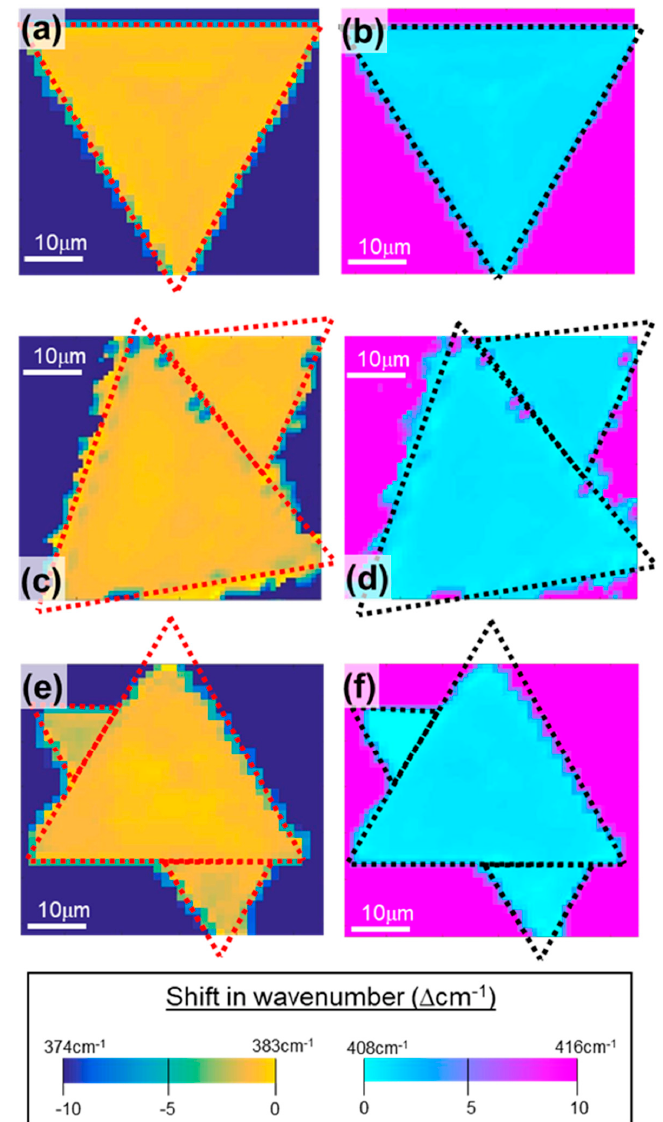
Figure 4. Raman mapping of MoS 2 crystal showing (left) E 1 2g peak at 383 cm − 1 and (right) A 1 g peak at 408 cm − 1 when grown at 750 °C for ( a , b ), 800 °C for ( c ) and ( d ), and 850 °C for ( e ) and ( f ).